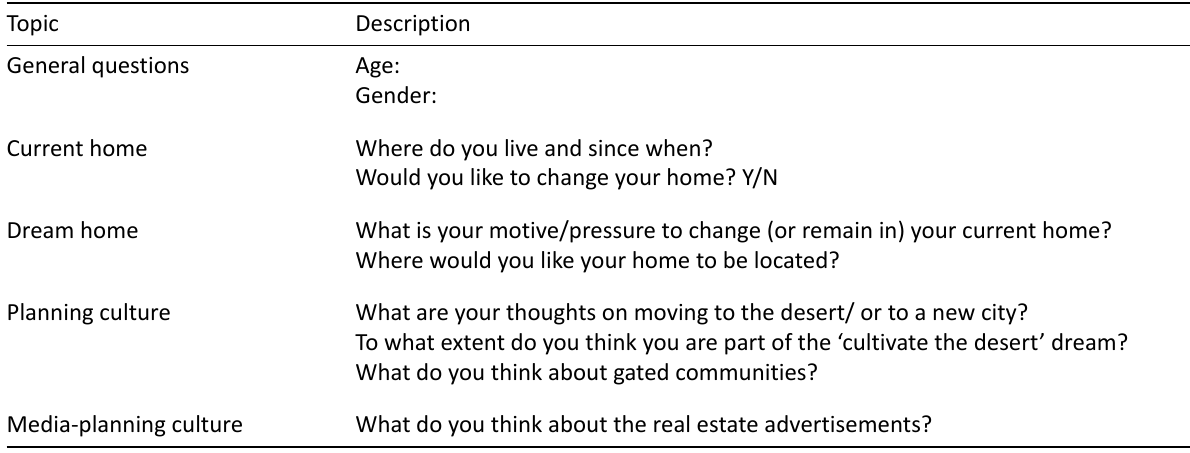
Table 2. Sample of questions discussed with